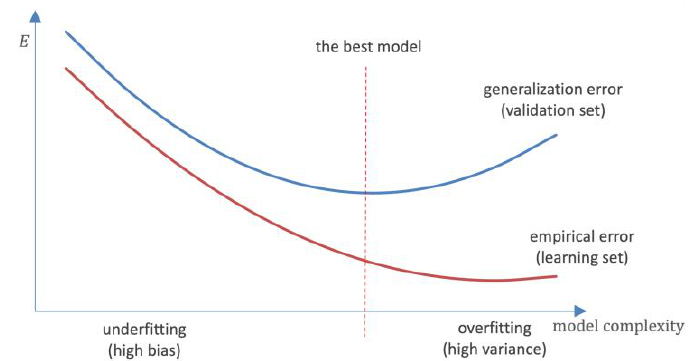
Figure A3. Optimal division by linear scanning. Source: Chen and Guestrin (2016).